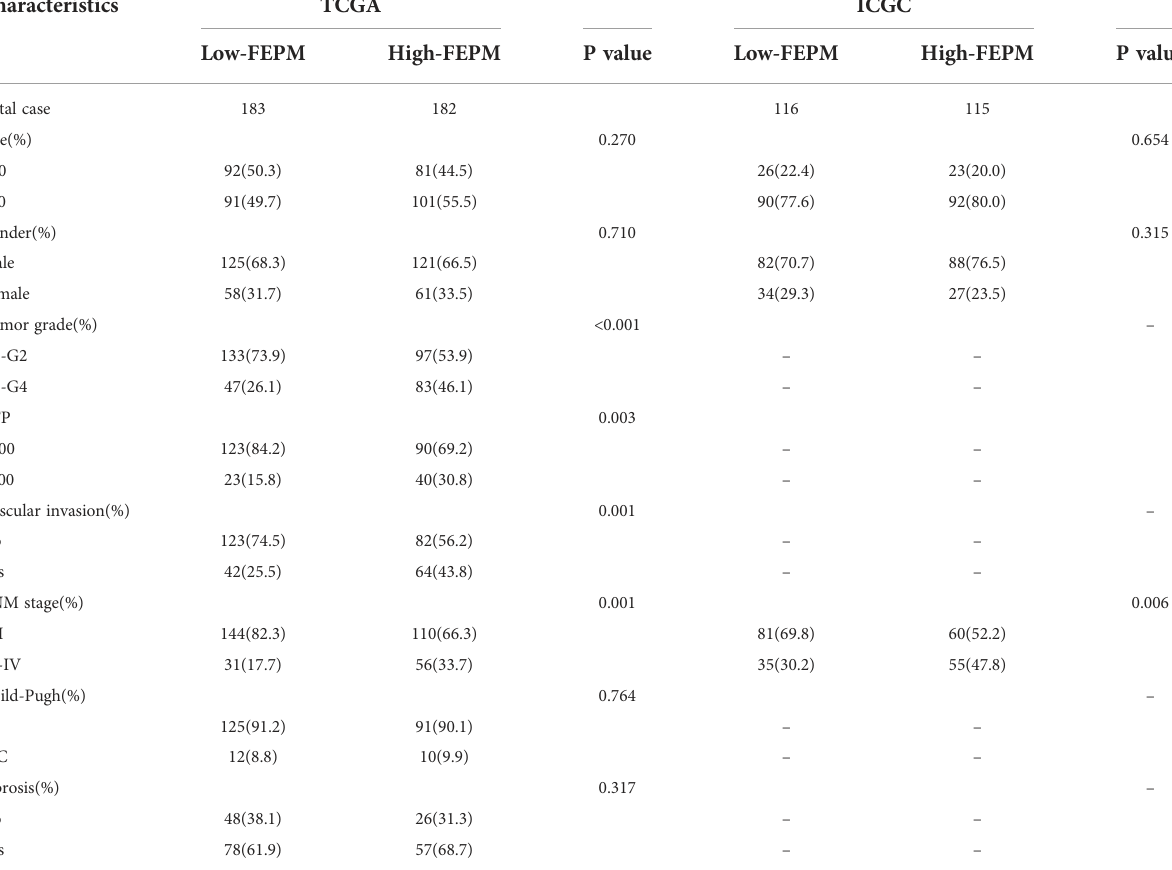
TABLE 3 Relationships between FEPM and clinicopathological features of HCC patients.